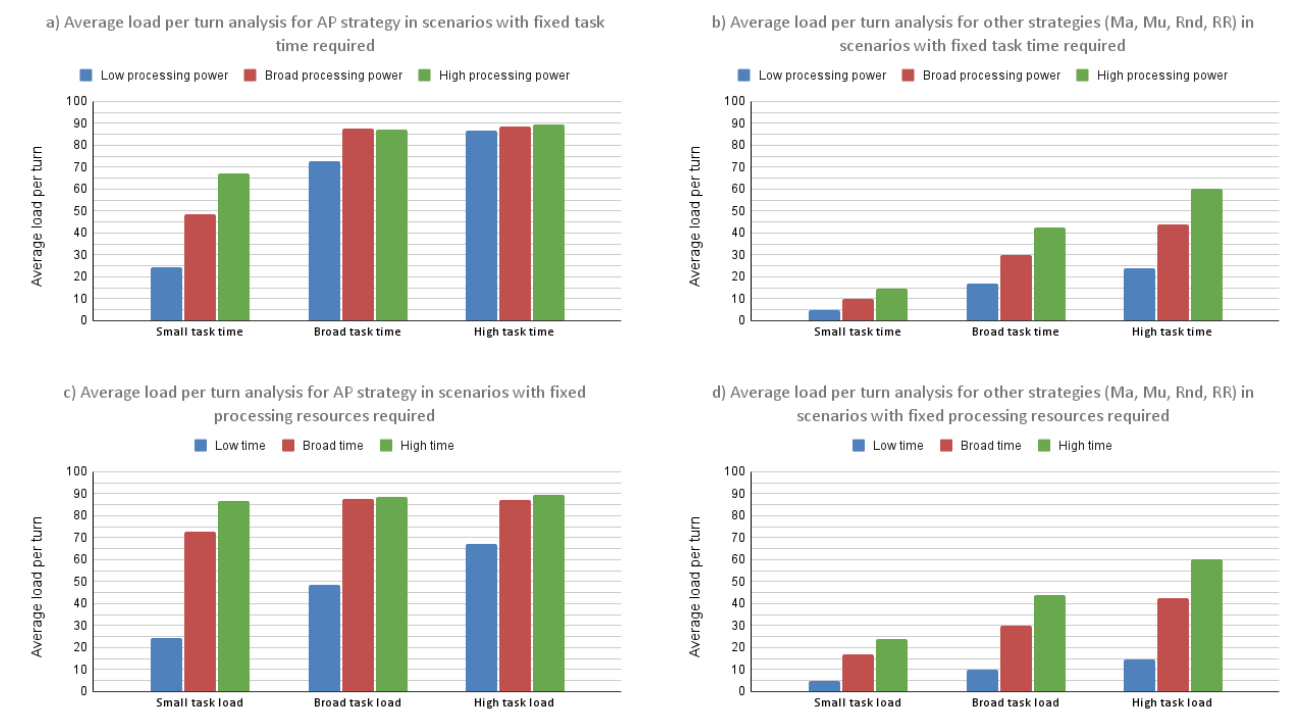
Figure 7. Average load per turn analysis based on average resources required, average task required processing time and distribution